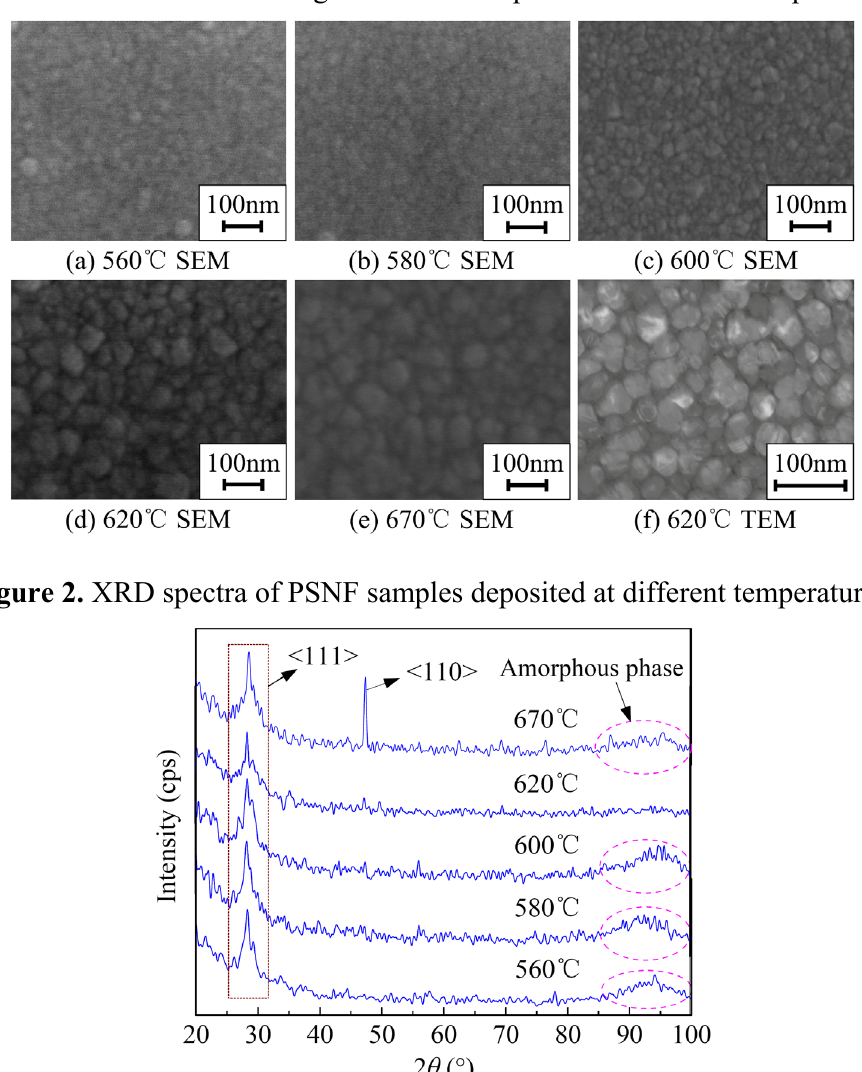
Figure 1. SEM and TEM images of PSNFs deposited at different temperatures.